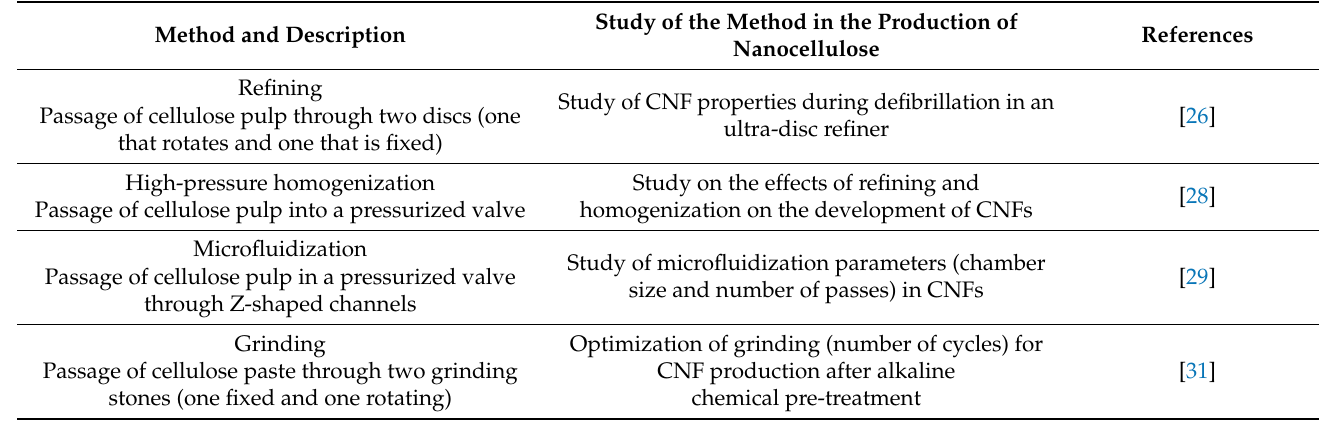
Table 2. Studies on the operational parameters of mechanical methods for nanocellulose preparation. Method and